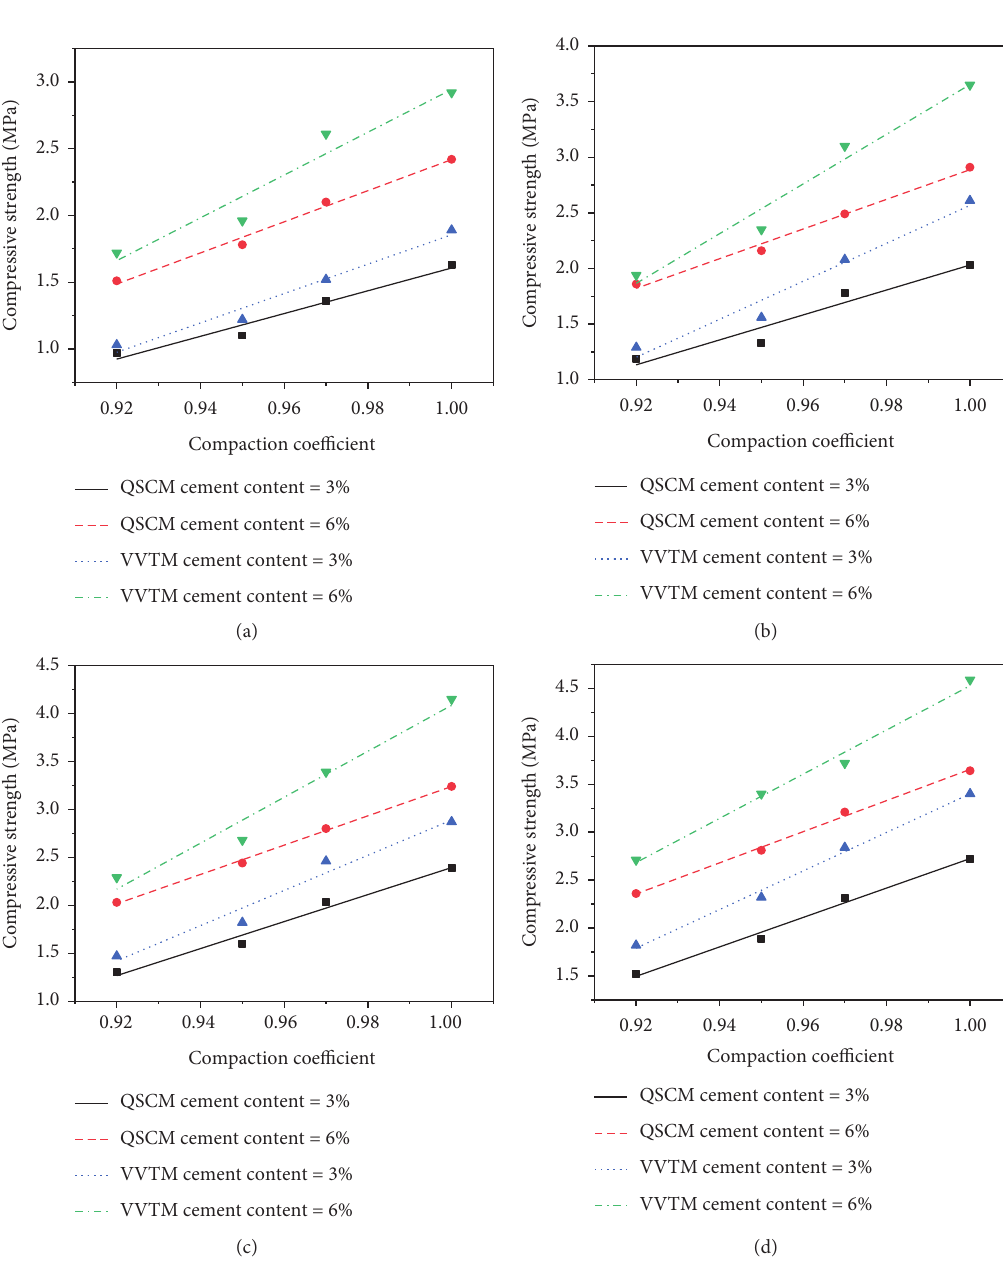
Figure 5: Influence of compaction coefficient on UCS of CSL compacted using VVCM and QSCM. (a) 7d. (b) 14d. (c) 28d. (d)